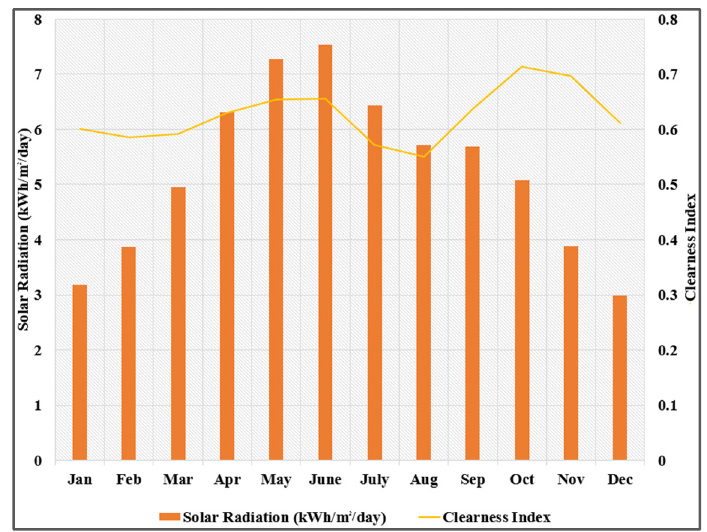
Figure 2. The average annual solar radiation in Islamabad.